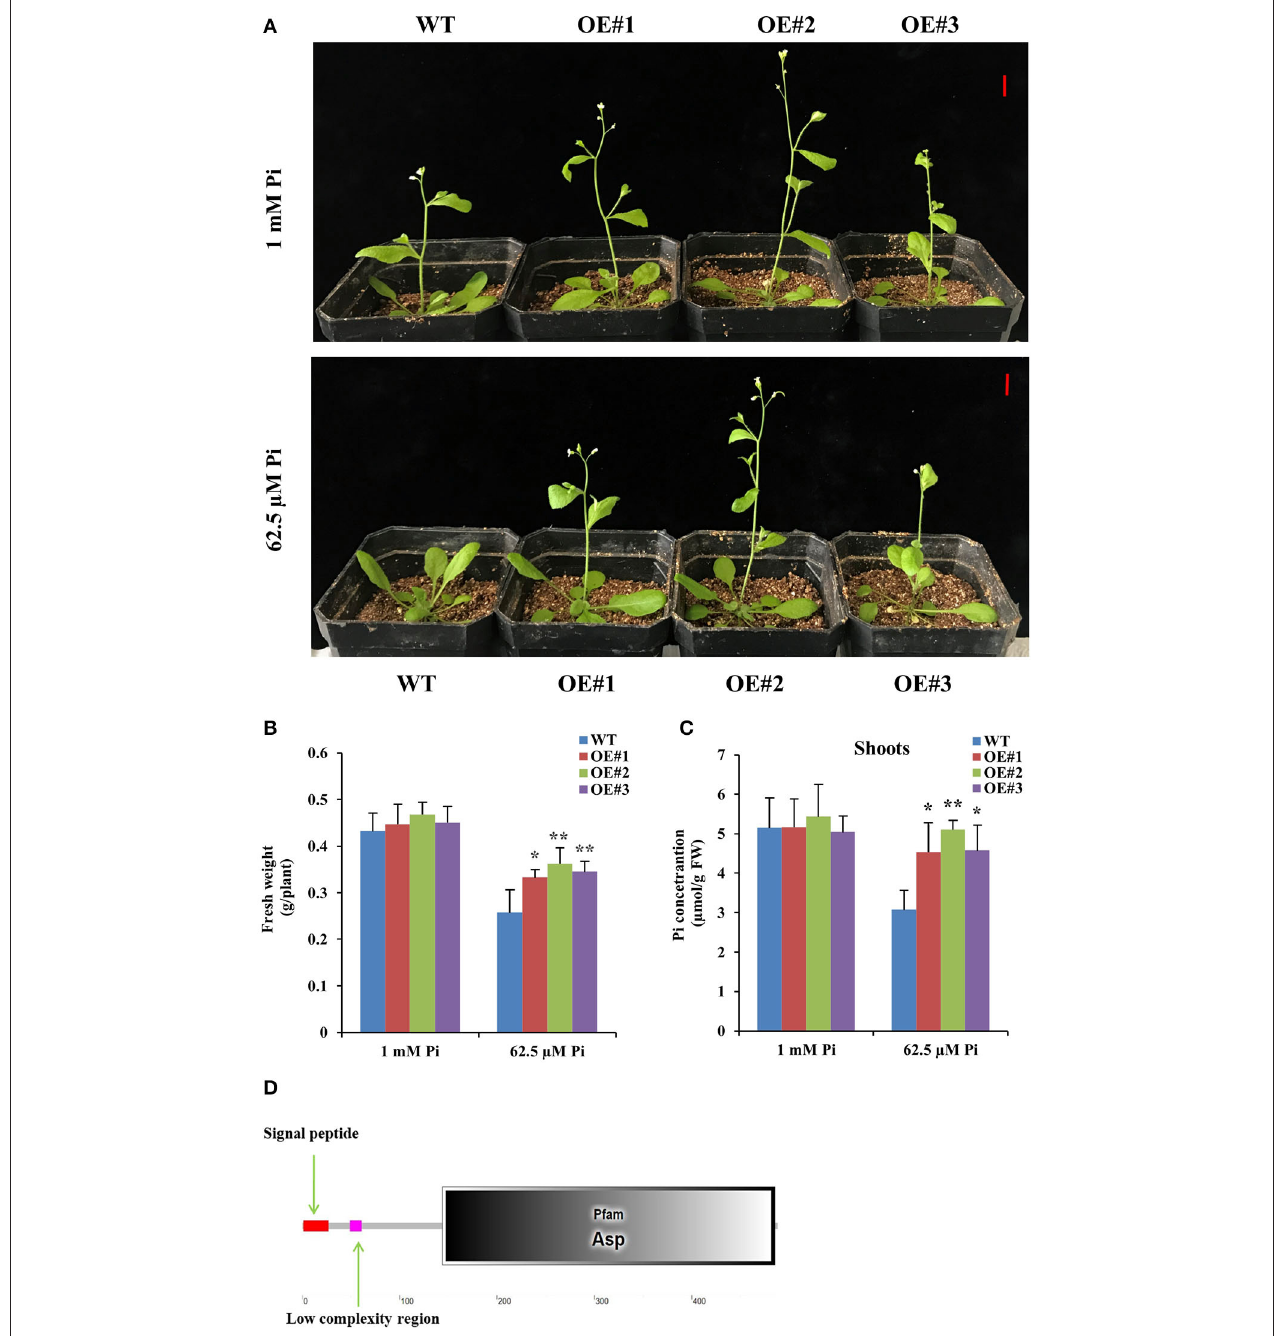
FIGURE 6 | Overexpression of DEG6 enhanced tolerance to Pi starvation in transgenic Arabidopsis . (A) Two-week-old seedlings were grown in the greenhouse for 20 days under 1mM Pi (Pi-sufficient) and 62.5 µ M Pi (Pi-deficient) conditions. WT, wild type Arabidopsis lines; OE#1 to 3, independent DEG6 -overexpresing Arabidopsis lines. Bars: 1cm. (B, C) The fresh weight and shoots Pi concentration of WT and DEG6 -overexpresing Arabidopsis on the 20th day. Data means ± SD ( n = 3). Asterisks indicated significant differences between transgenic Arabidopsis and WT (Student’s t -test, * P < 0.05; ** P < 0.01). (D) Protein domain analysis of